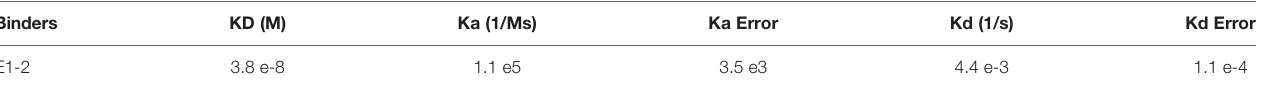
TABLE 4 | SPR of CD22 speci fi c VH domain E1-2.